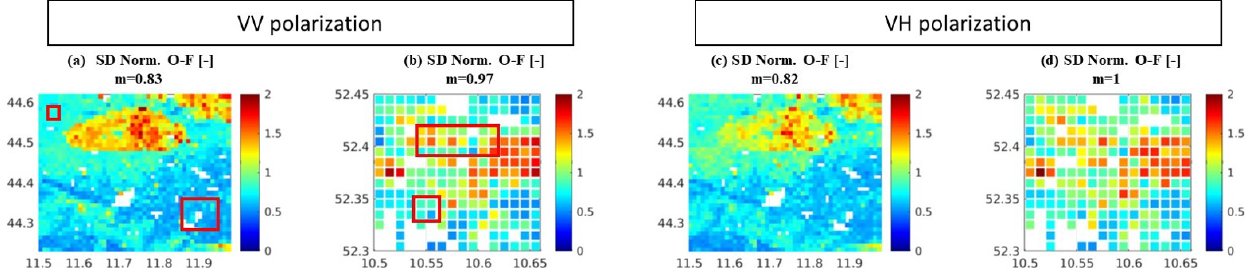
Figure 4. Maps of the standard deviation (SD) of the normalized O − F residuals for Sentinel-1 γ 0 VV DA (a) in Italy and (b) in Germany; Sentinel-1 γ 0 VH DA (c) in Italy and (d) in Germany. m is the mean over the entire study area. Red boxes in (a) and (b) indicate areas where the test sites are located. The reference period is January 2015–December 2020. No Sentinel-1 data were assimilated in the white areas (Fig.